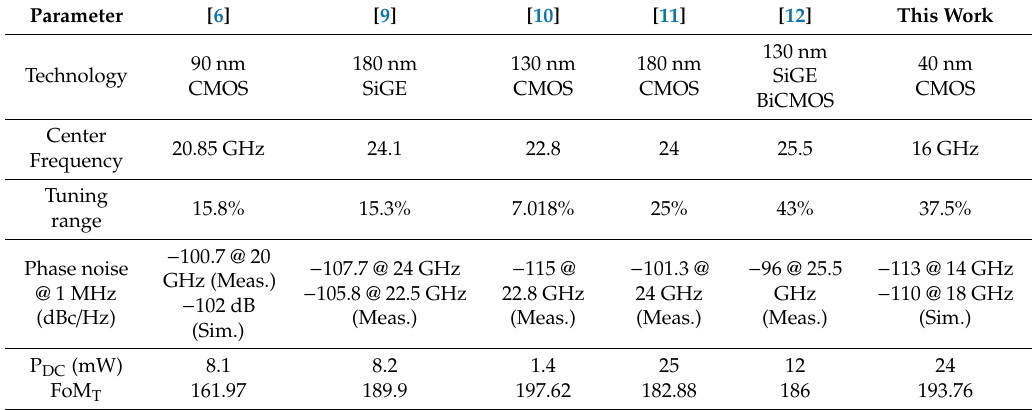
Table 2. Comparison of the proposed VCO with the other